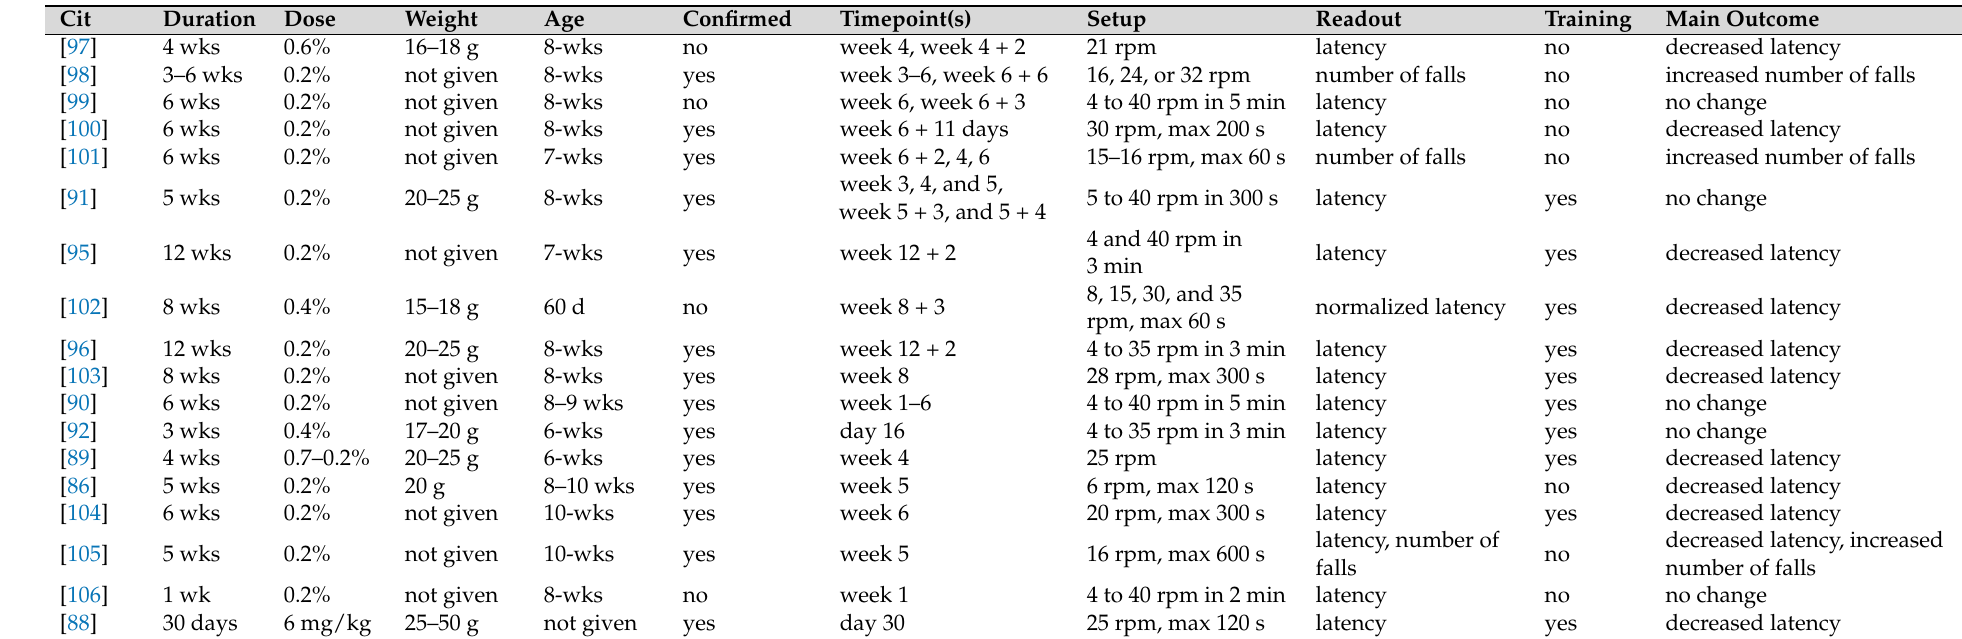
Table 1. Summary of behavioral studies in the cuprizone model using the rotarod testing paradigm. Column 1 (Cit): Citation of the study; Column 2 (Duration): Duration of cuprizone intoxication; Column 3 (Dose): Applied cuprizone dose; Column 4 (Weight): Weight of the mice at the beginning of the cuprizone intoxication; Column 5 (Age): Age of the animals at the beginning of the cuprizone intoxication; Column 6 (Confirmed): Indication whether or not demyelination was histologically confirmed; Column 7 (Timepoint(s)): Timepoints at which rotarod testing was performed. “+” indicates the duration of the remyelination period. For example, week 6 + 3 indicates that 3 wks of remyelination were allowed after a 6-wk cuprizone intoxication period; Column 8 (Setup): Applied experimental setup of the rotarod test; Column 9 (Readout): Parameter used to evaluate motor performance using the rotarod testing paradigm; Column 10 (Training): Indication whether or not a training session or multiple training session were performed prior to the analysis; Column 11 (Main outcome): Main findings of the study. Rpm (revolutions per minute); wks